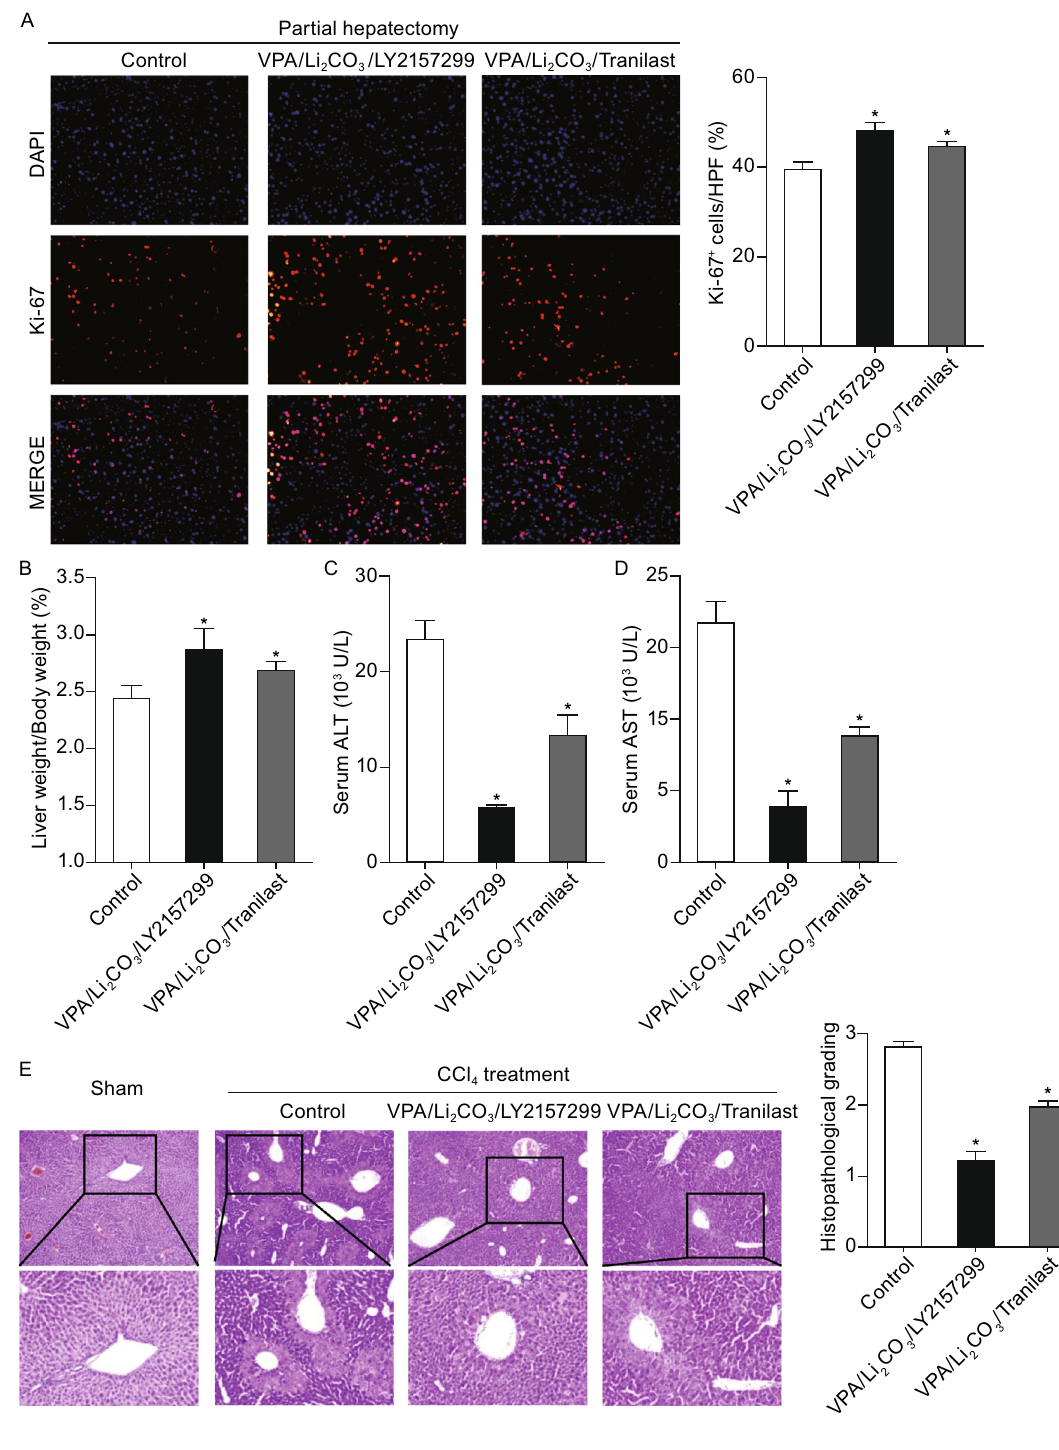
Figure 3. Drug cocktails protect liver from acute injuries. (A and B) Drug cocktails protect liver from acute injury induced by partial hepatectomy (PHx). (A) Representative images of Ki-67 positive cells (red) at 48 h after PHx are shown in the left panels. Nuclei were stained with DAPI. Right panels show quanti fi cation of Ki-67 positive (Ki-67 + ) cells. HPF, high-power fi elds. (B) Assessment of liver regeneration treated with drug cocktailsafter PHxby measuring ratio between liver weightandbody weight. (C – E) Drug cocktails protect liverfromacuteinjuryinducedbyCCl 4 treatment.(CandD)Serumalaninetransaminase(ALT)andaspartatetransaminase(AST)activity wereanalyzed24hafterCCl 4 treatment.(E)Representativeimagesoftheliverhistopathologicalchangesareshownintheleftpanelsand quanti fi cation of histopathological grading is shown in the right panel. All data are presented as mean ± SD. * P < 0.05 vs.